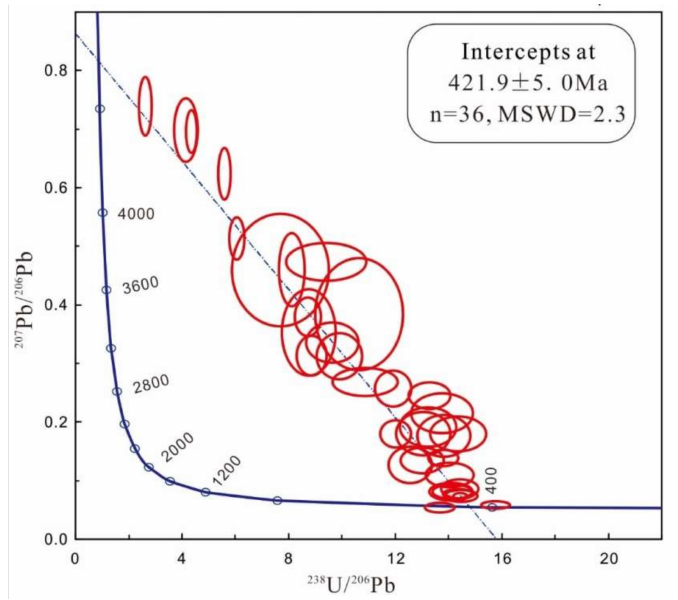
Figure 5. U–Pb concordia diagram for cassiterite from the Jialong Sn–Cu